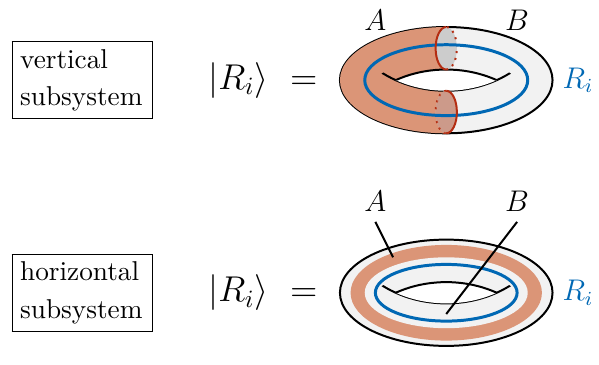
Figure 8 . Topological entanglement entropy of states on a solid torus with a Wilson loop insertion. There are two ways to choose the subsystem A on the surface; the vertical subsystem [Above] and horizontal subsystem